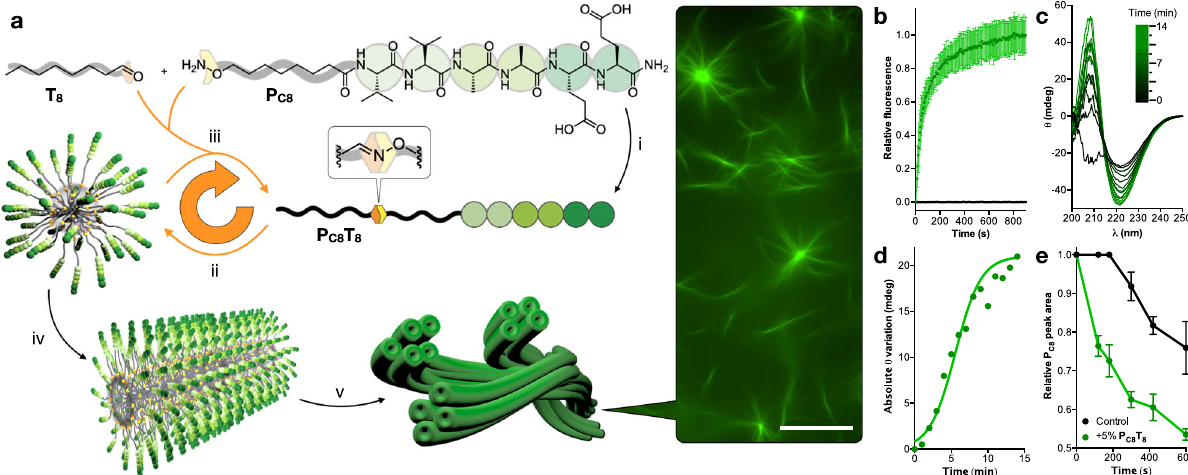
Fig. 1 Autocatalytic formation of peptide-based micro fi bres. a Schematic showing: (i) precursor peptide P C8 reacting with octanal ( T 8 ) to form the peptide amphiphile product, P C8 T 8 , though an oxime connection; (ii) micellar aggregation of the product P C8 T 8 ; (iii) co-assembly of P C8 T 8 with its precursors and the resulting physically autocatalytic behaviour (circular orange arrow); (iv, v) Hierarchical elongation into individual nano fi bres and micro fi brillar bundles, which can be seen by fl uorescence microscopy stained with ThT. Scale bar = 20 µ m. b Time-dependent ThT emission from an aqueous P C8 solution after addition of T 8 (green) and without T 8 (black); n = 3 (mean ± SD). c Time-dependent CD spectra of the reaction after addition of T 8 . d Change in CD signal (222 nm) during the reaction. e P C8 consumption in reaction with T 8 (1 mM) either in the absence (control) or presence of pre- formed P C8 T 8 product (5% mol/mol) followed by HPLC (222 nm); n = 3 (mean ±